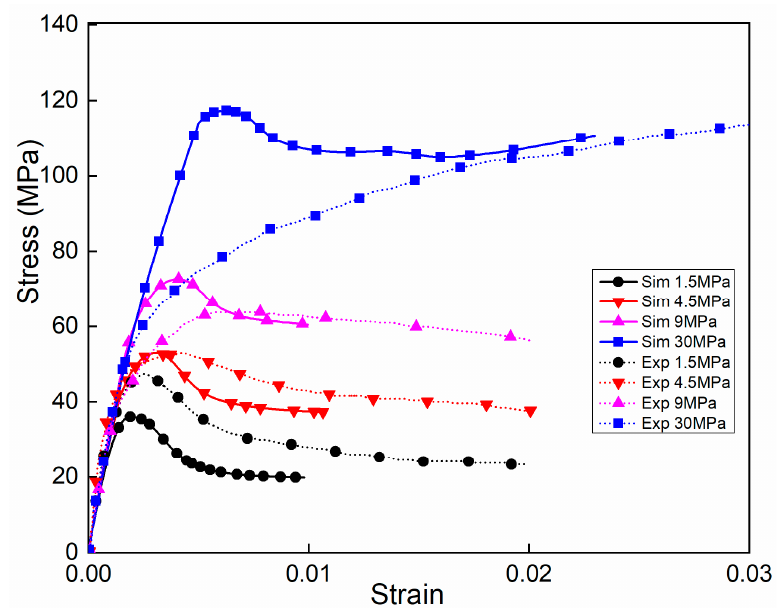
Figure 7. Triaxial compression skeleton diagram. With equal confining stresses ( σ 1 / σ 3 = 1) along the horizontal direction, Figure 8 illustrates the stress–strain curves of experimental tests and numerical simulations under different compressive stresses. Experimental data were obtained from [15], where the confining pressure ranged from 0 to 30 MPa. The confining pressure was applied to the concrete specimens by changing the value of the hydrostatic pressure.